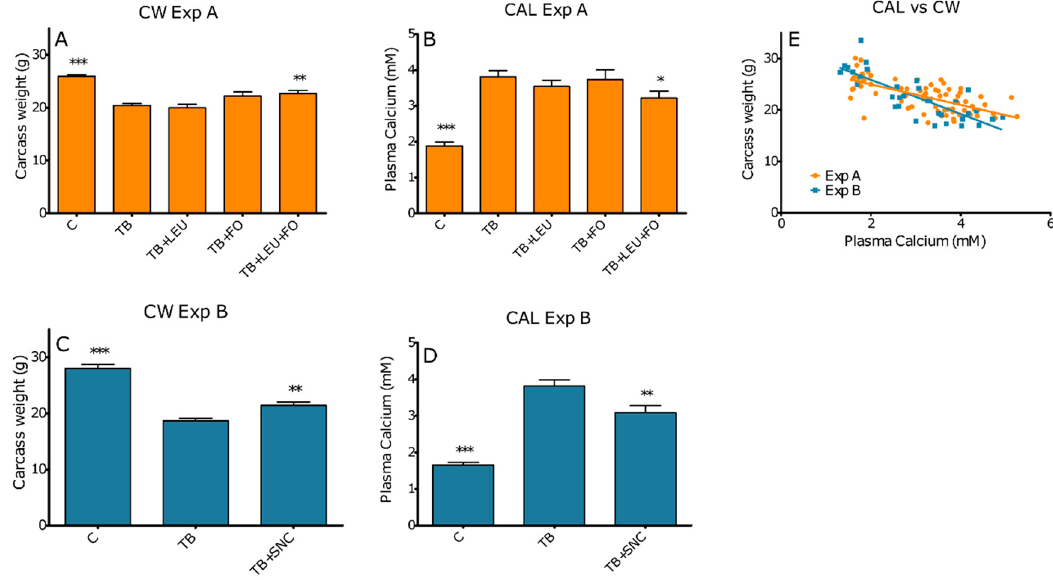
Figure 1. Effect of leucine (LEU), fish oil (FO) and a combination of leucine and fish oil on carcass weight and plasma Ca 2+ levels ( A , B ); and effect of a specific nutritional combination (SNC) containing added fish oil and leucine on carcass weight and plasma Ca 2+ levels ( C , D ). Data represent mean ± SEM. Correlation between carcass weight and plasma Ca 2+ levels (Pearson r = − 0.6684 [Experiment A] and − 0.8097 [Experiment B], both with p < 0.0001) ( E ). *, ** and *** represent significant differences with tumour-bearing (TB) group (respectively, p < 0.05, p < 0.01 and p < 0.001).